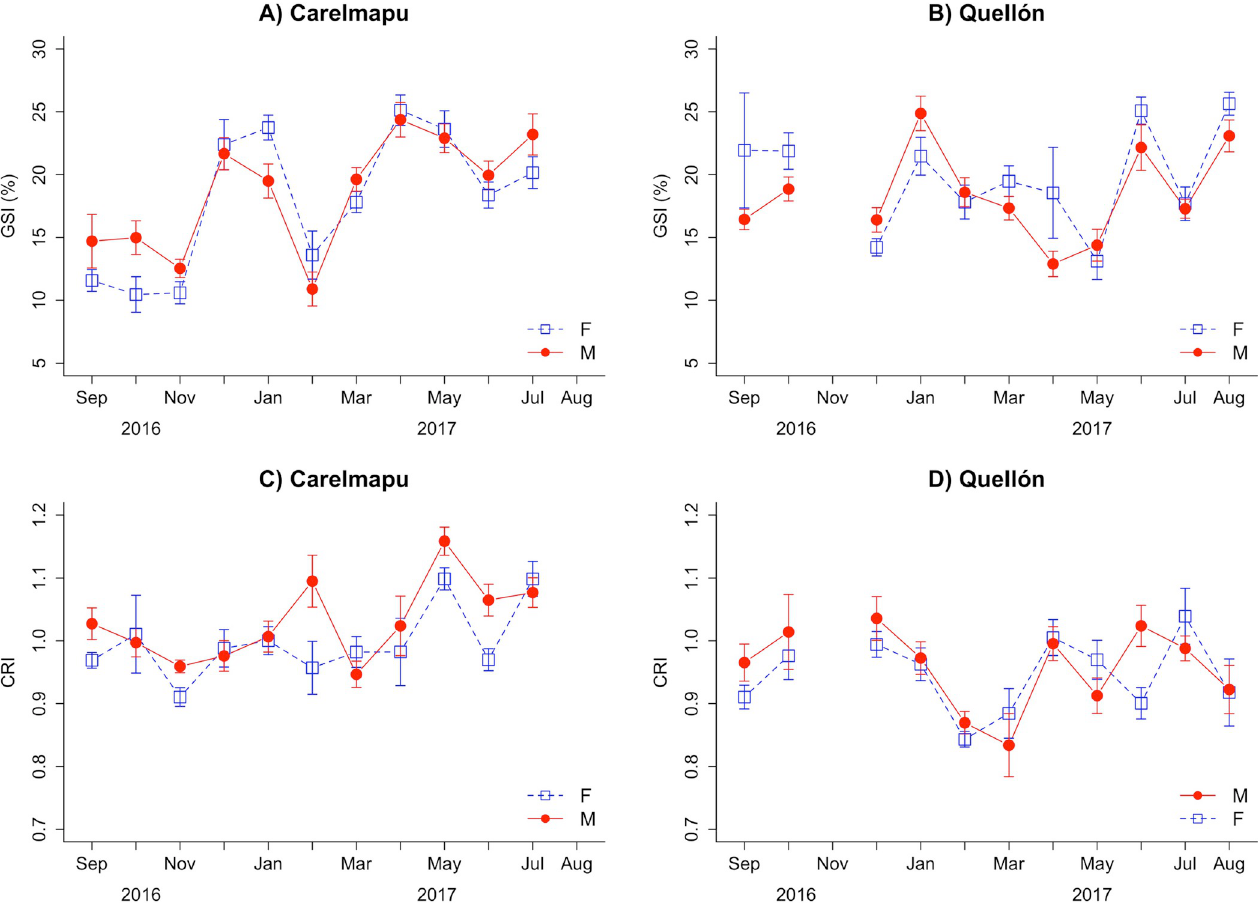
Fig 1. Monthly variation of the Gonadosomatic Index (GSI) and Relative Condition Index (RCI) of the chilean clam A . antiqua in natural beds. (A) Gonadosomatic Index in natural beds at Carelmapu. (B) Gonadosomatic Index in natural beds at Quello´n. (C) Relative Condition Index in Carelmapu. (D) Relative Condition Index in Quello´n. The error bars correspond to standard